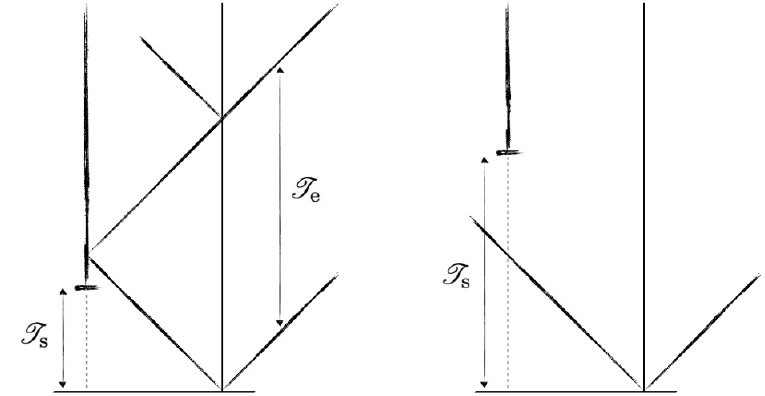
Figure 1 . Diagram showing the interplay between the two timescales involved: the timescale T s of formation of the re(cid:13)ective surface and the echo timescale T e